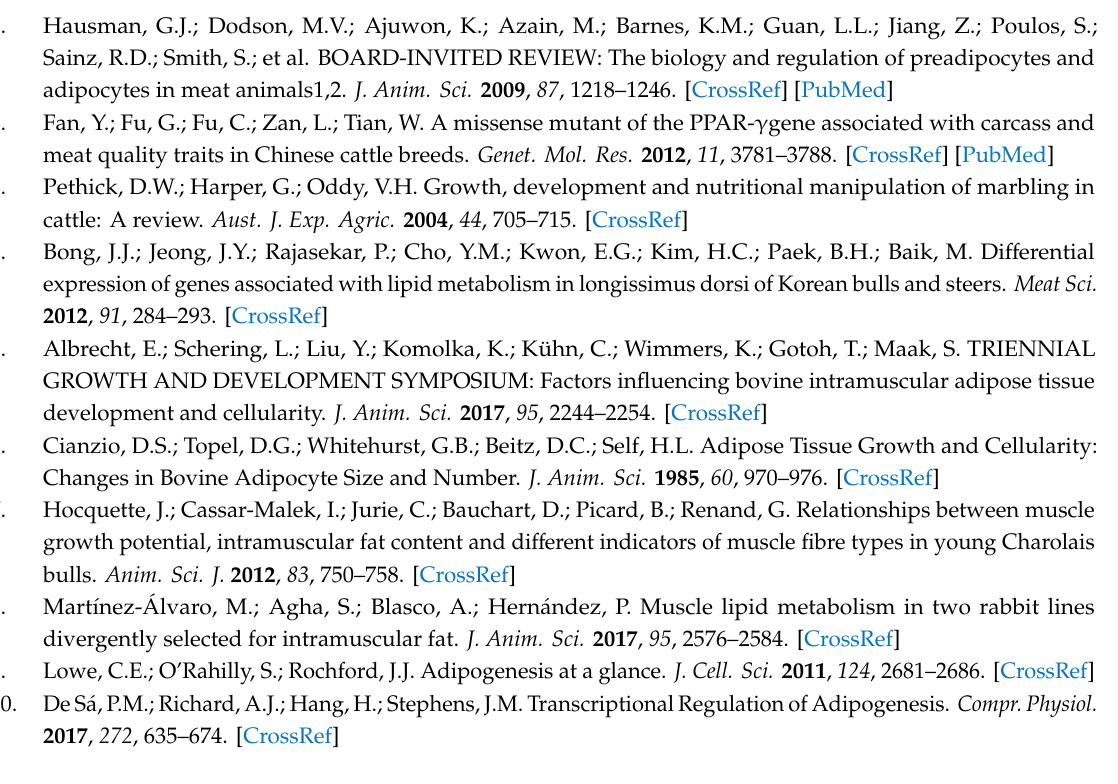
Table S1: DE miRNAs gene targets predicted by IPA; Table S2: GO term and KEGG pathway analyses (complete